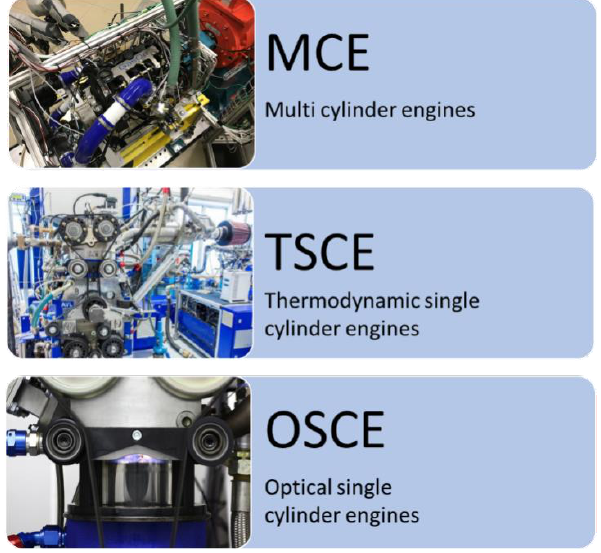
Fig. 3. Research engines types [14, 22, 32,